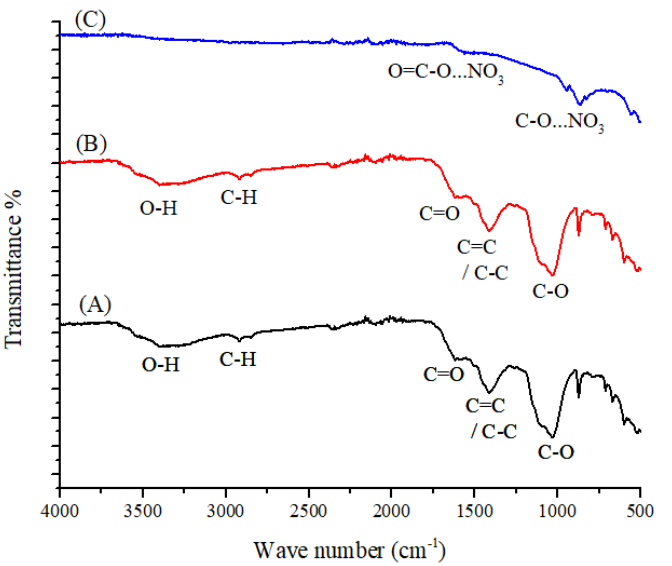
Figure 2. FT-IR spectra of ( A ) SMC, ( B ) SMCB/Fe before nitrate adsorption, and ( C ) SMCB/Fe after nitrate adsorption.